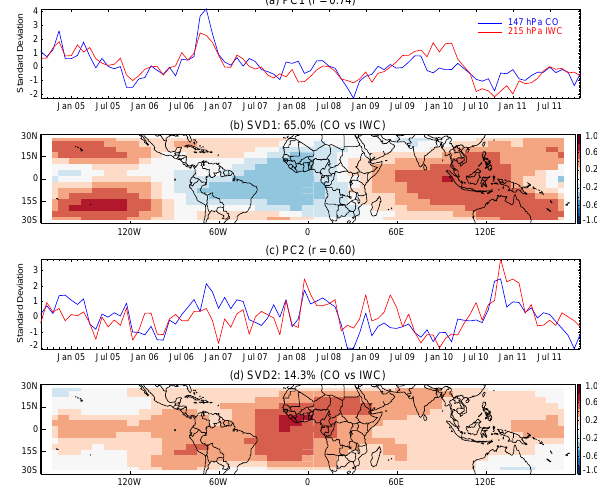
Fig. 4. SVD analysis results of 147hPa CO and 215hPa IWC for the period of August 2004–December 2011: (a) principle compo- nents (PCs) of 147hPa CO (blue) and 215hPa IWC (red) for the first SVD mode, (b) heterogeneous correlation map of 147hPa CO (i.e., correlation between 147hPa CO and the PC of 215hPa IWC) for the first SVD mode, (c) PCs of 147hPa CO (blue) and 215hPa IWC (red) for the second SVD mode, and (d) heterogeneous corre- lation map of 147hPa CO for the second SVD